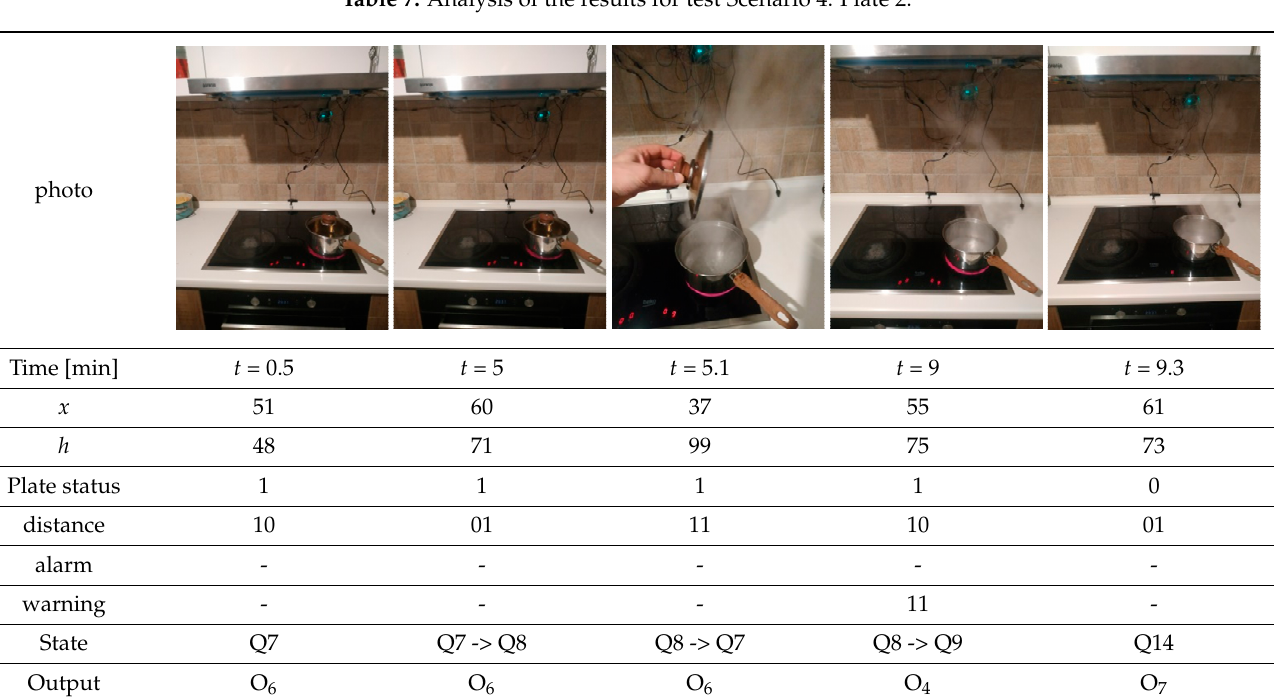
Figure 8. Test results of Scenario 4. Table 7. Analysis of the results for test Scenario 4: Plate 2.